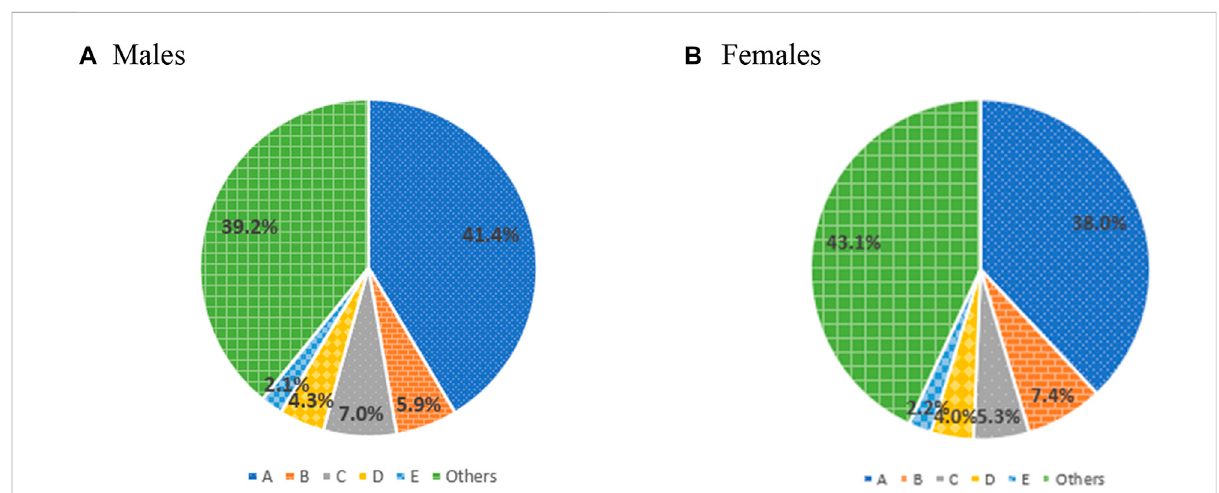
FIGURE 2 Prevalence of frequent type of adverse drug events by sex. A, allergy, unspeci fi ed; B, other drug-induced secondary parkinsonism; C, generalized skin eruption due to drugs and medicaments; D, allergic contact dermatitis due to drugs in contact with skin; E, unspeci fi ed adverse event of drug or